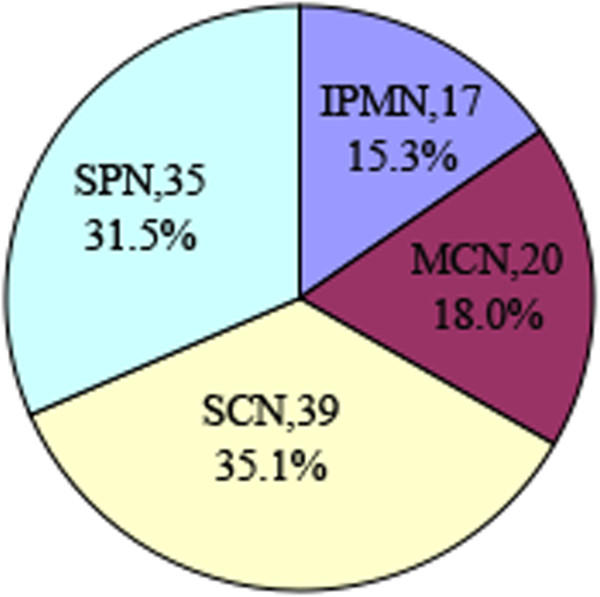
Distribution of PCNs in 111 patients.